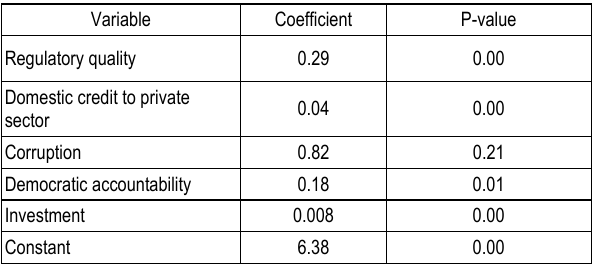
Table 4. Growth and institutional quality